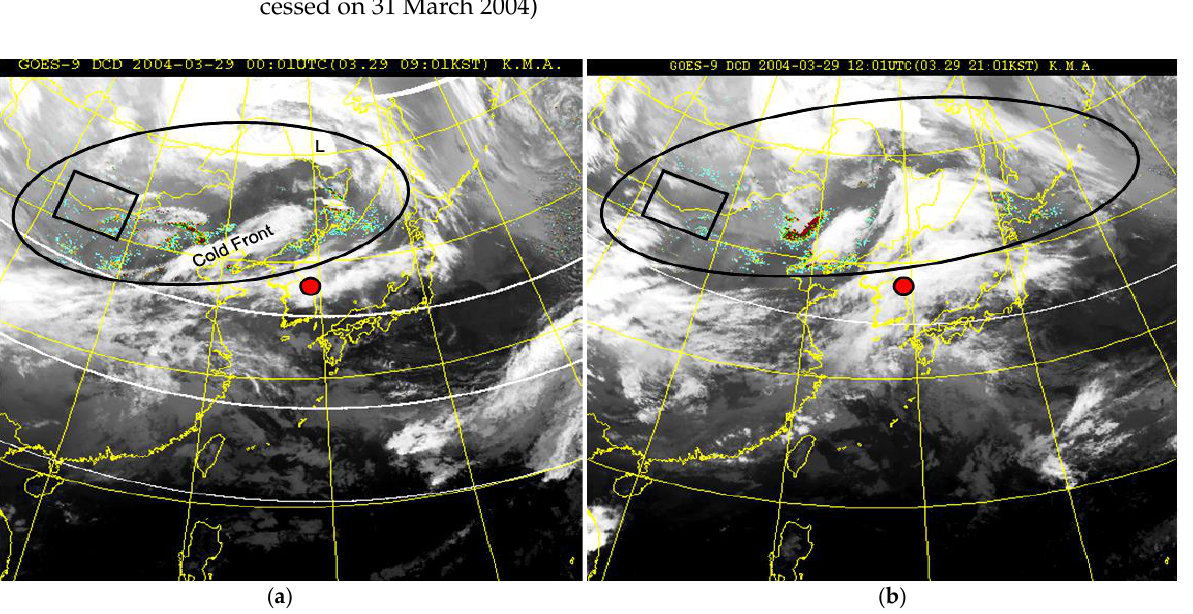
Figure 3 . GOES-9-DCD satellite picture at ( a ) 09:01 LST, 29 March 2004, and ( b ) 21:01 LST. The blue color area denotes the dust originating from the Gobi Desert (a small square) on the left of Cold Front to move toward Nei-Mongo in the east of the desert and southern Manchuria near the border of northern Korea. The large circle and small one denote the area of dust dispersion and Gangneung city of Korea, respectively.